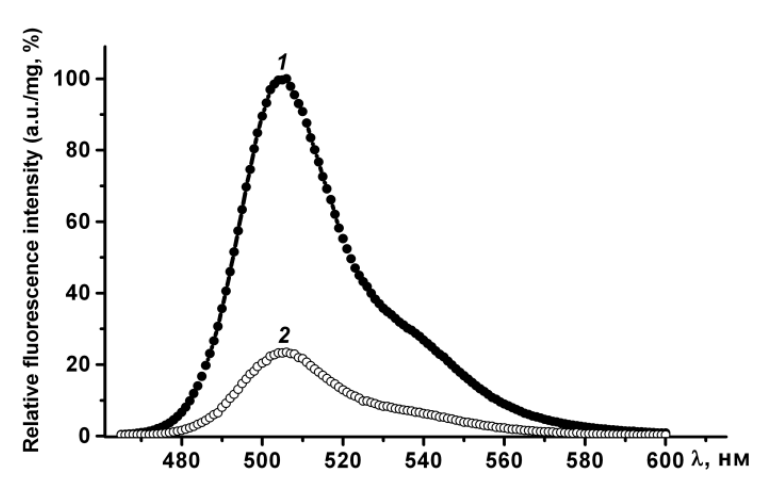
Figure 4. GFP fluorescence emission spectra of recombinant proteins in PBS: (1) GFP, (2) PldA-GFP IВs. The fluorescence intensity of GFP calculated per 1 mg of protein was taken as 100%.